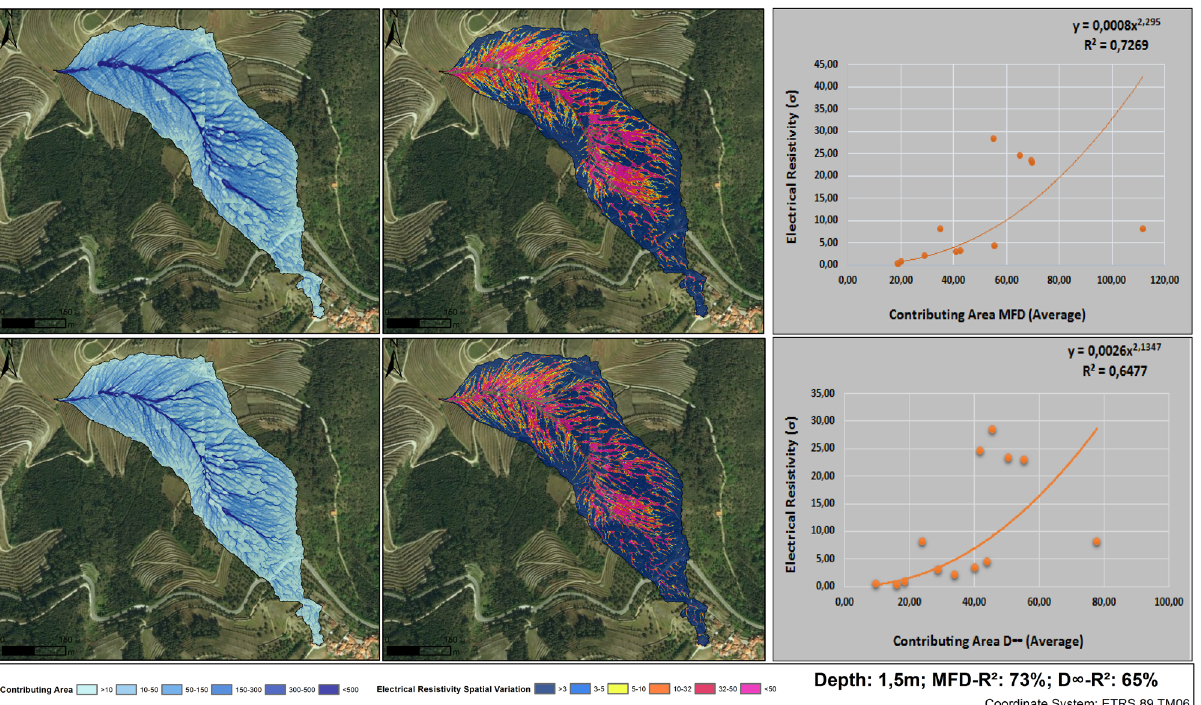
Figure 7: Soil electrical spatial variation at 1.5 meter of depth